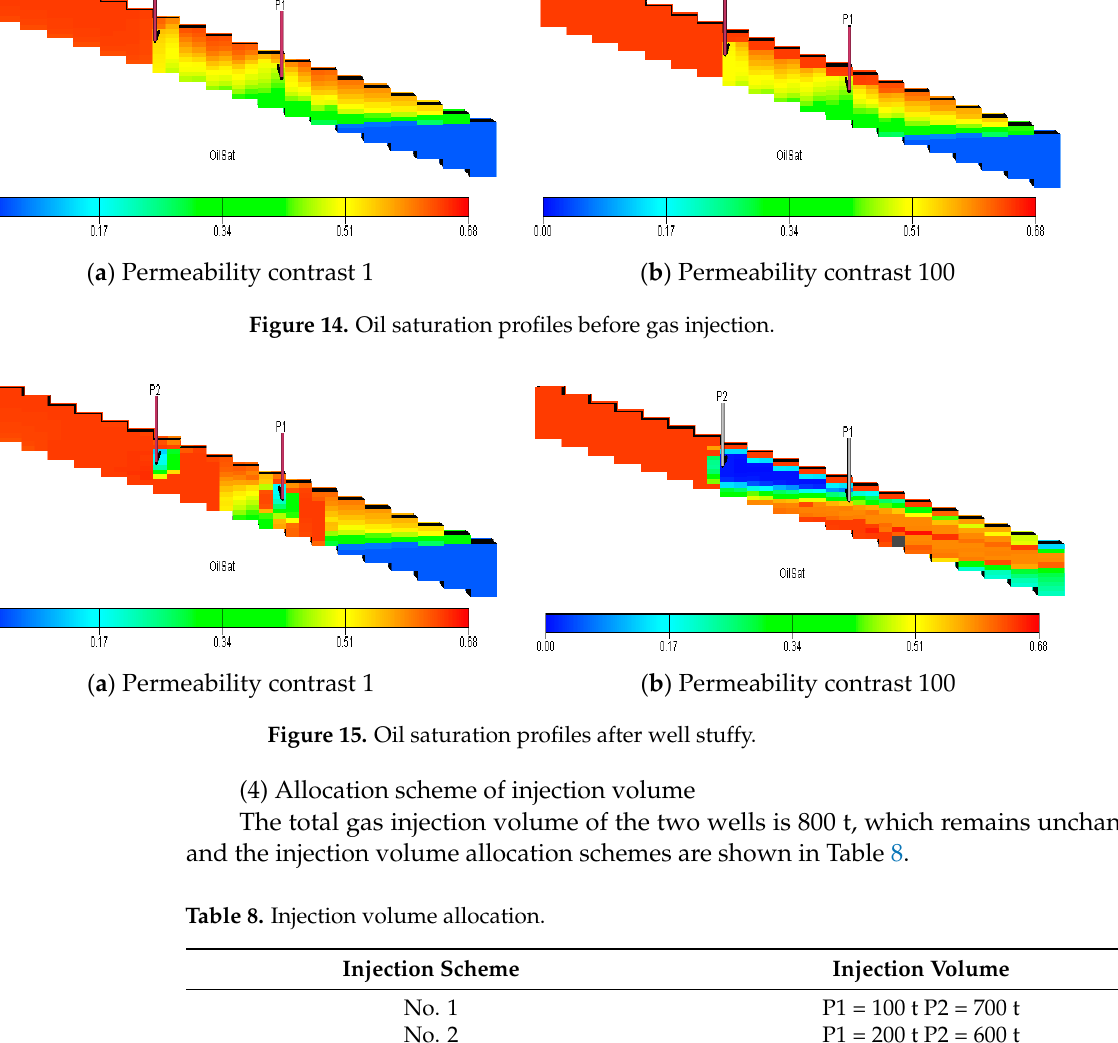
Figure 13. Channel level difference to the GOR of well P2.